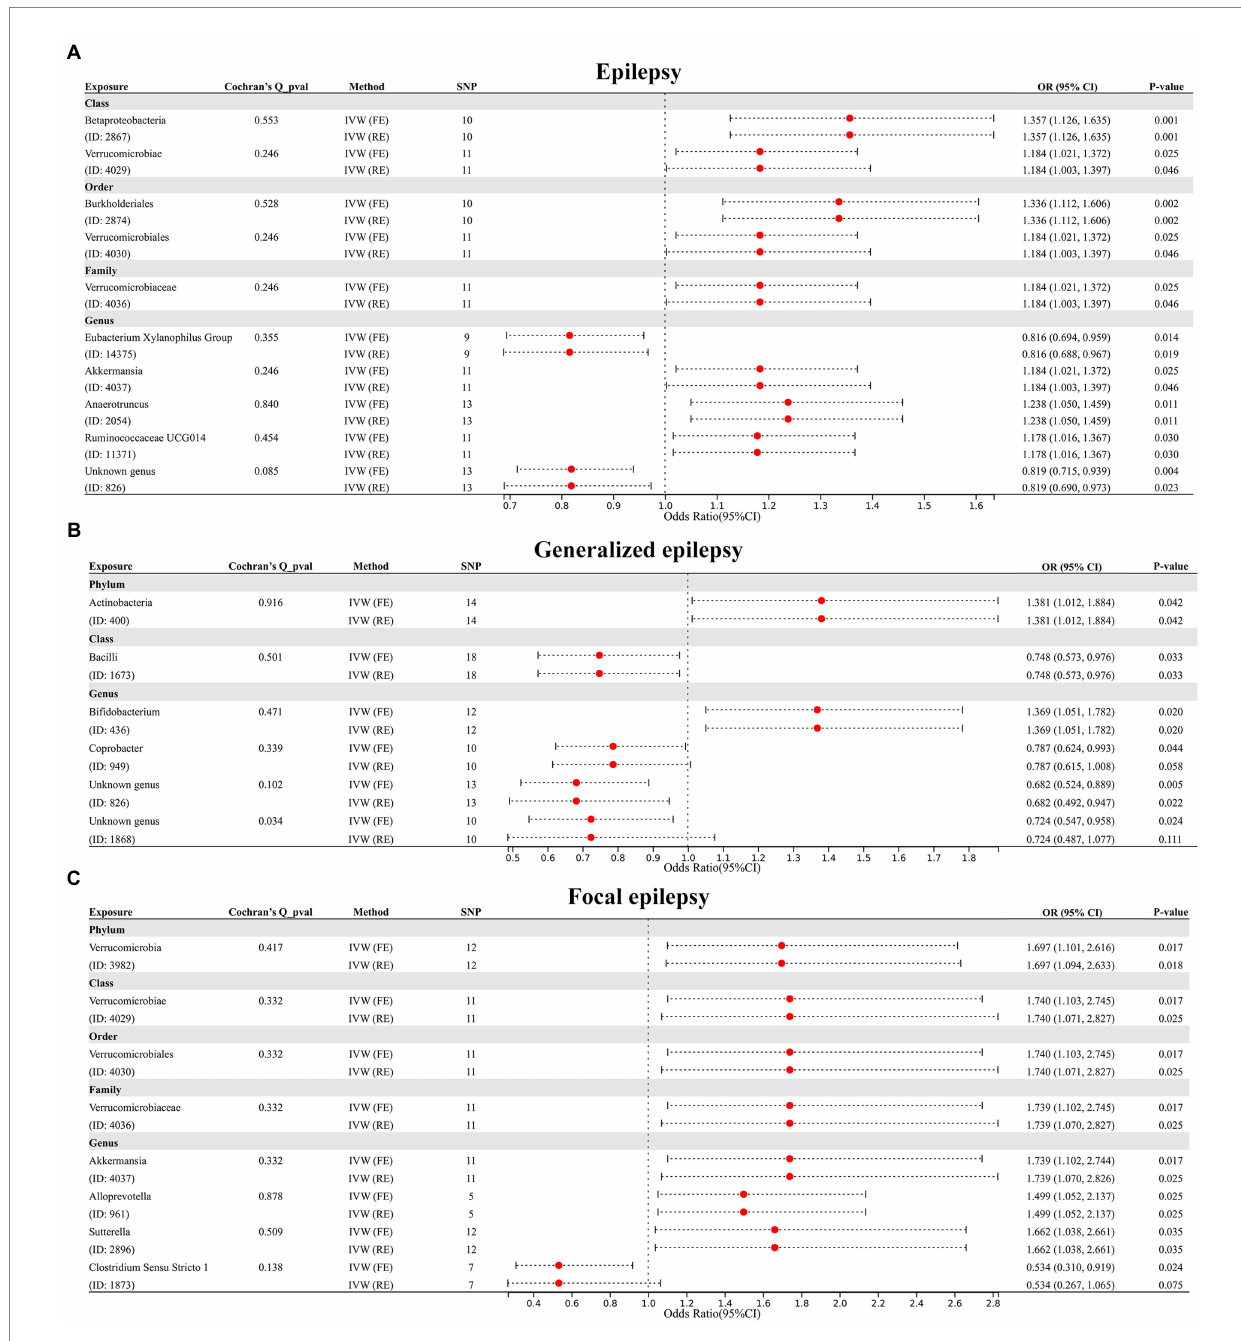
FIGURE 2 (A) Forest plot of GM taxa associated with epilepsy identified by IVW_FE method. (B) Forest plot of GM taxa associated with generalized epilepsy identified by IVW_FE method. (C) Forest plot of GM taxa associated with focal epilepsy identified by IVW_FE